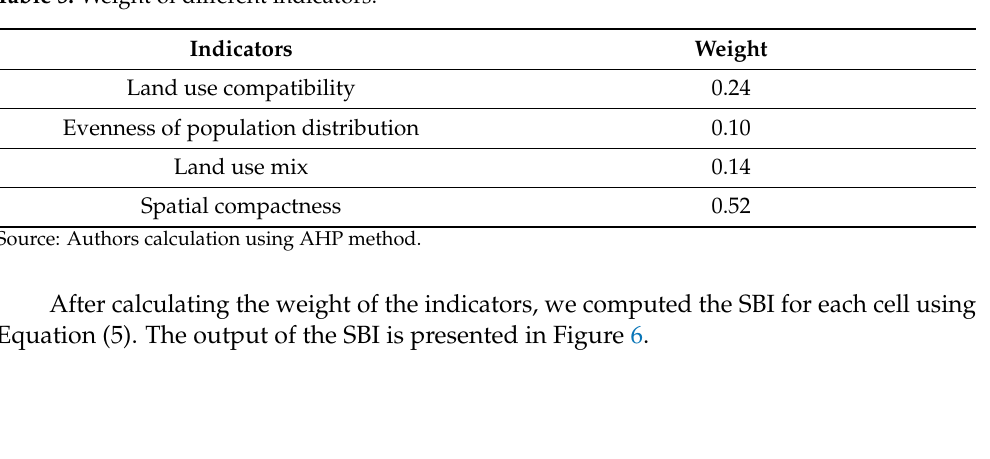
Table 5. Weight of different